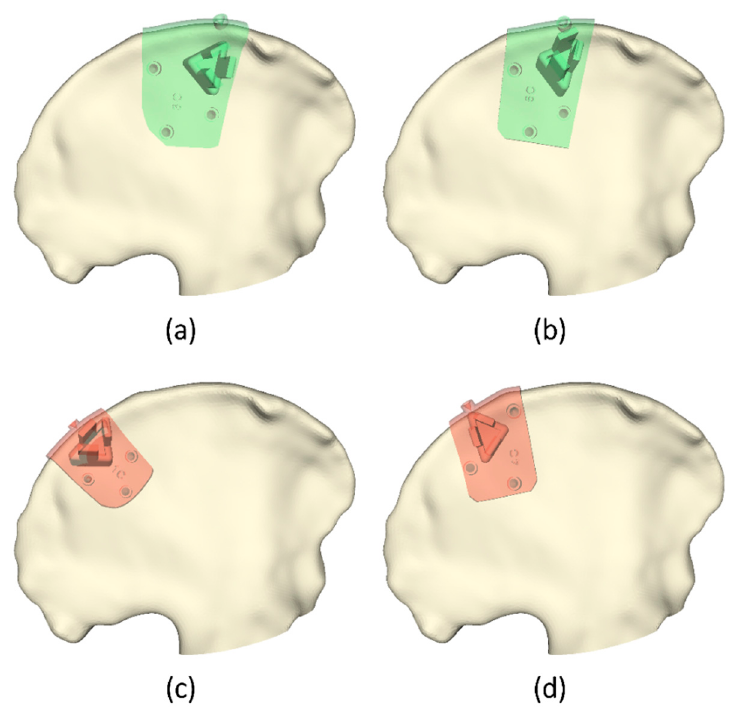
Figure 6. Cases with iliac crest PSIs presenting significant differences with each other. The figures represent the cases with ( a , b ) lower and ( c , d ) higher